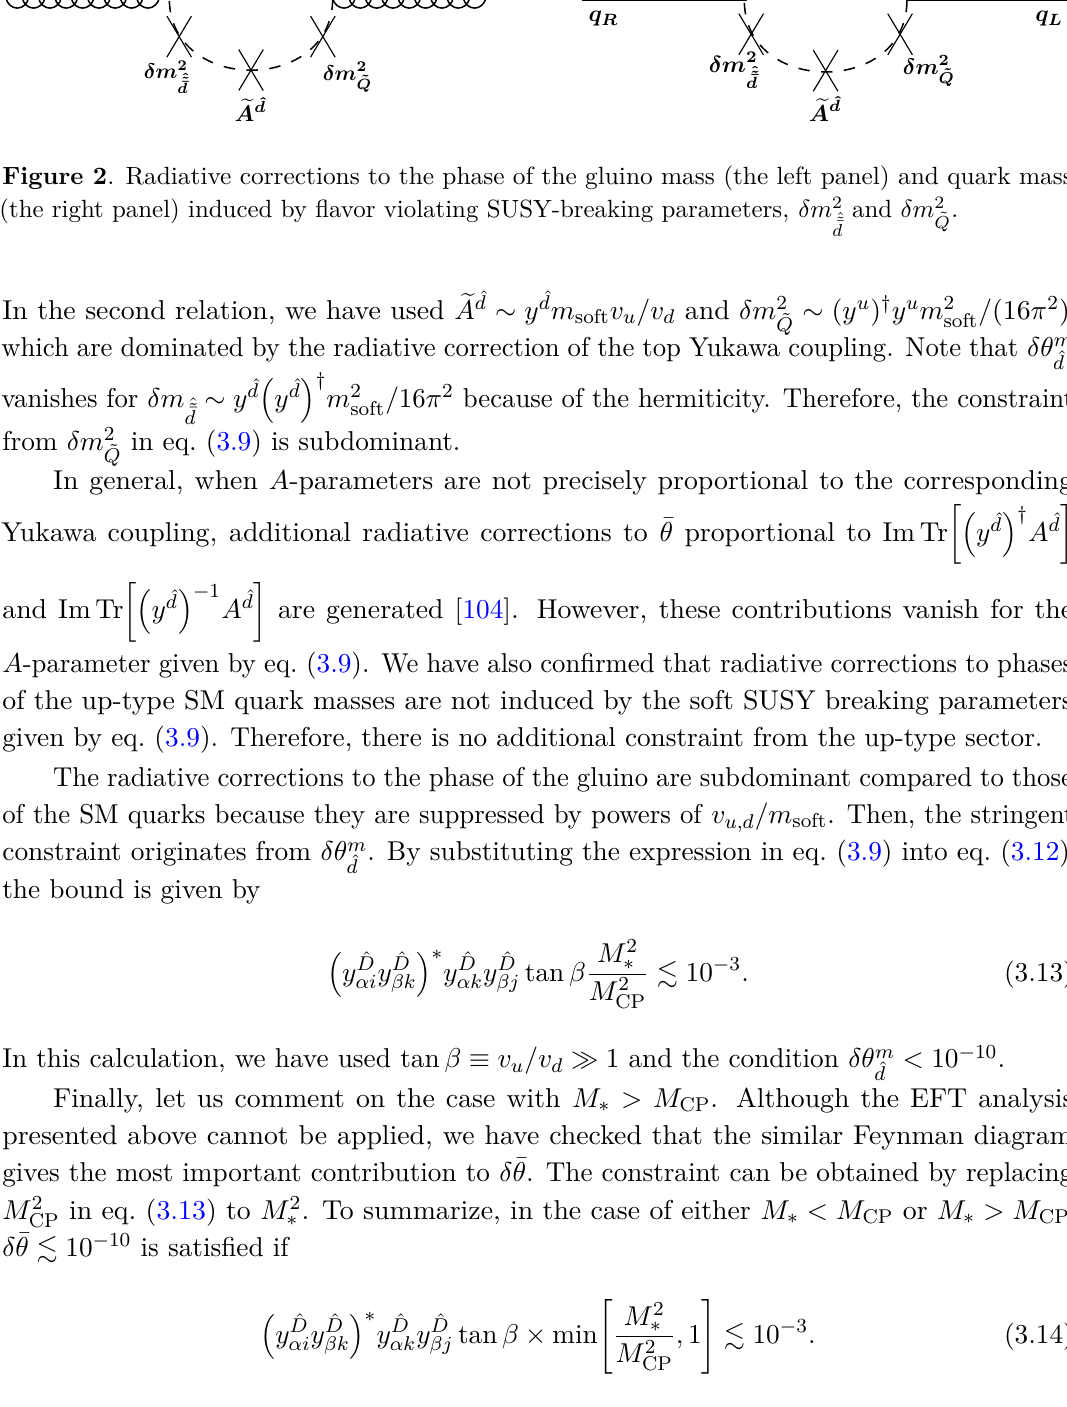
and δm 2 . ˜ Q ˆ˜¯ d v /v and δm 2 ∼ ( y u ) † y u m 2 / (16 π 2 ) , u soft d ˜ Q soft ˆ d